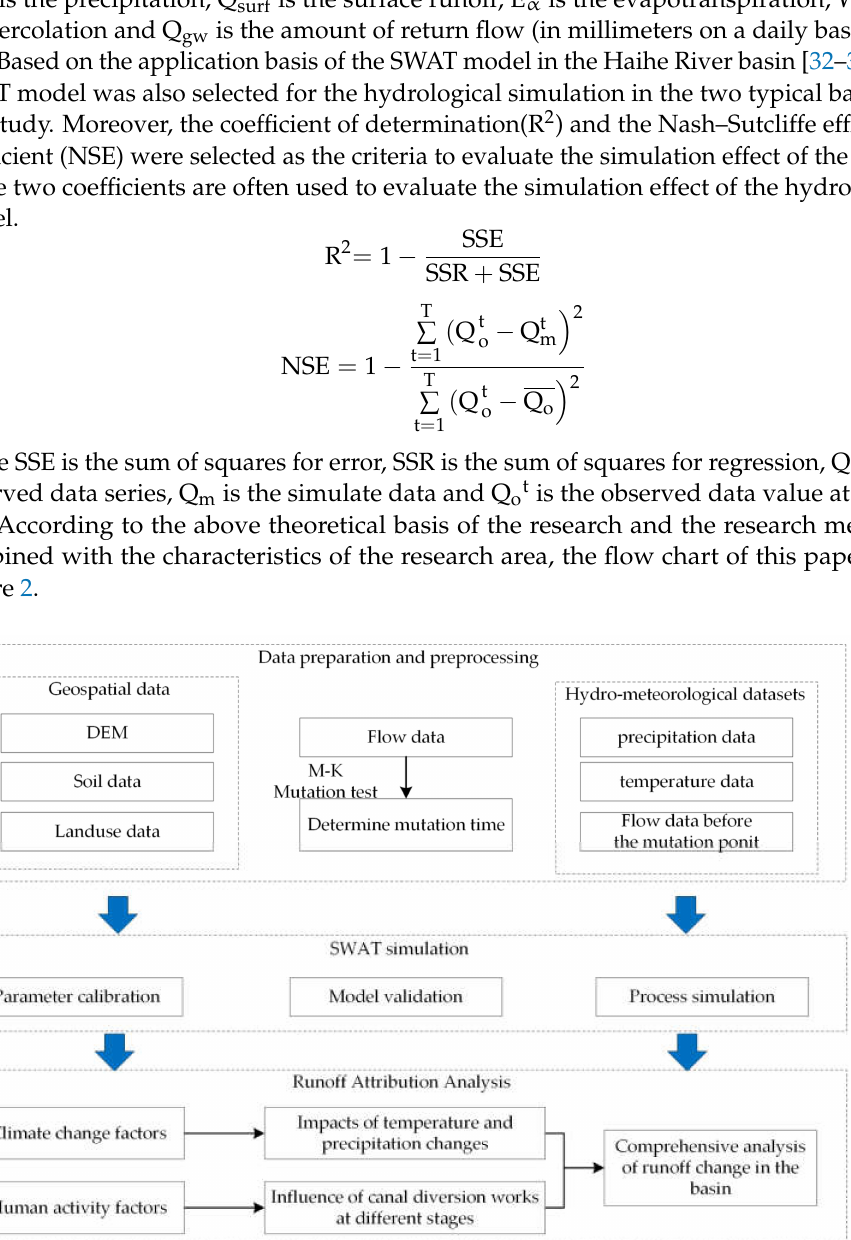
Figure 2. Flow chart of this